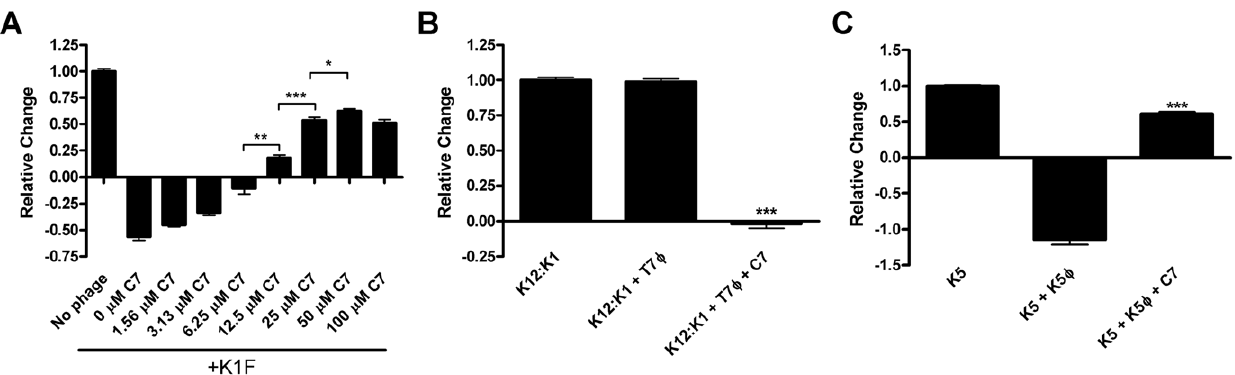
Figure 2. C7 inhibition of K1 and K5 capsule dependent phage lysis. ( A ) C7 inhibits K1 capsule-dependent phage lysis of UPEC. UPEC K1 strain UTI89 was grown in the presence of 1% DMSO or indicated concentrations of C7 for 1 hr and K1F phage was added where indicated. Relative OD 600 change after 4 hrs is shown. Increasing C7 concentrations inhibit lysis of UPEC K1. P value: , 0.0001 No C7 (0 m M) compared to each of C7 treatments . 12.5 m M. ( B ) C7 sensitizes K12:K1 strain to T7 phage. The K12 strain EV36 producing K1 capsule was infected with T7 phage (T7 w ), which is inhibited by the presence of K1 capsule. Addition of 100 m M C7 sensitized EV36 to T7 phage (p= , 0.0001). (C) C7 inhibits K5 capsule-dependent phage lysis. UPEC K5 strain DS17 was incubated with (K5 w ) or without phage and relative change in OD 600 was recorded. Addition of 100 m M C7 prevented lysis by K5 capsule specific phage (p , 0.0001).